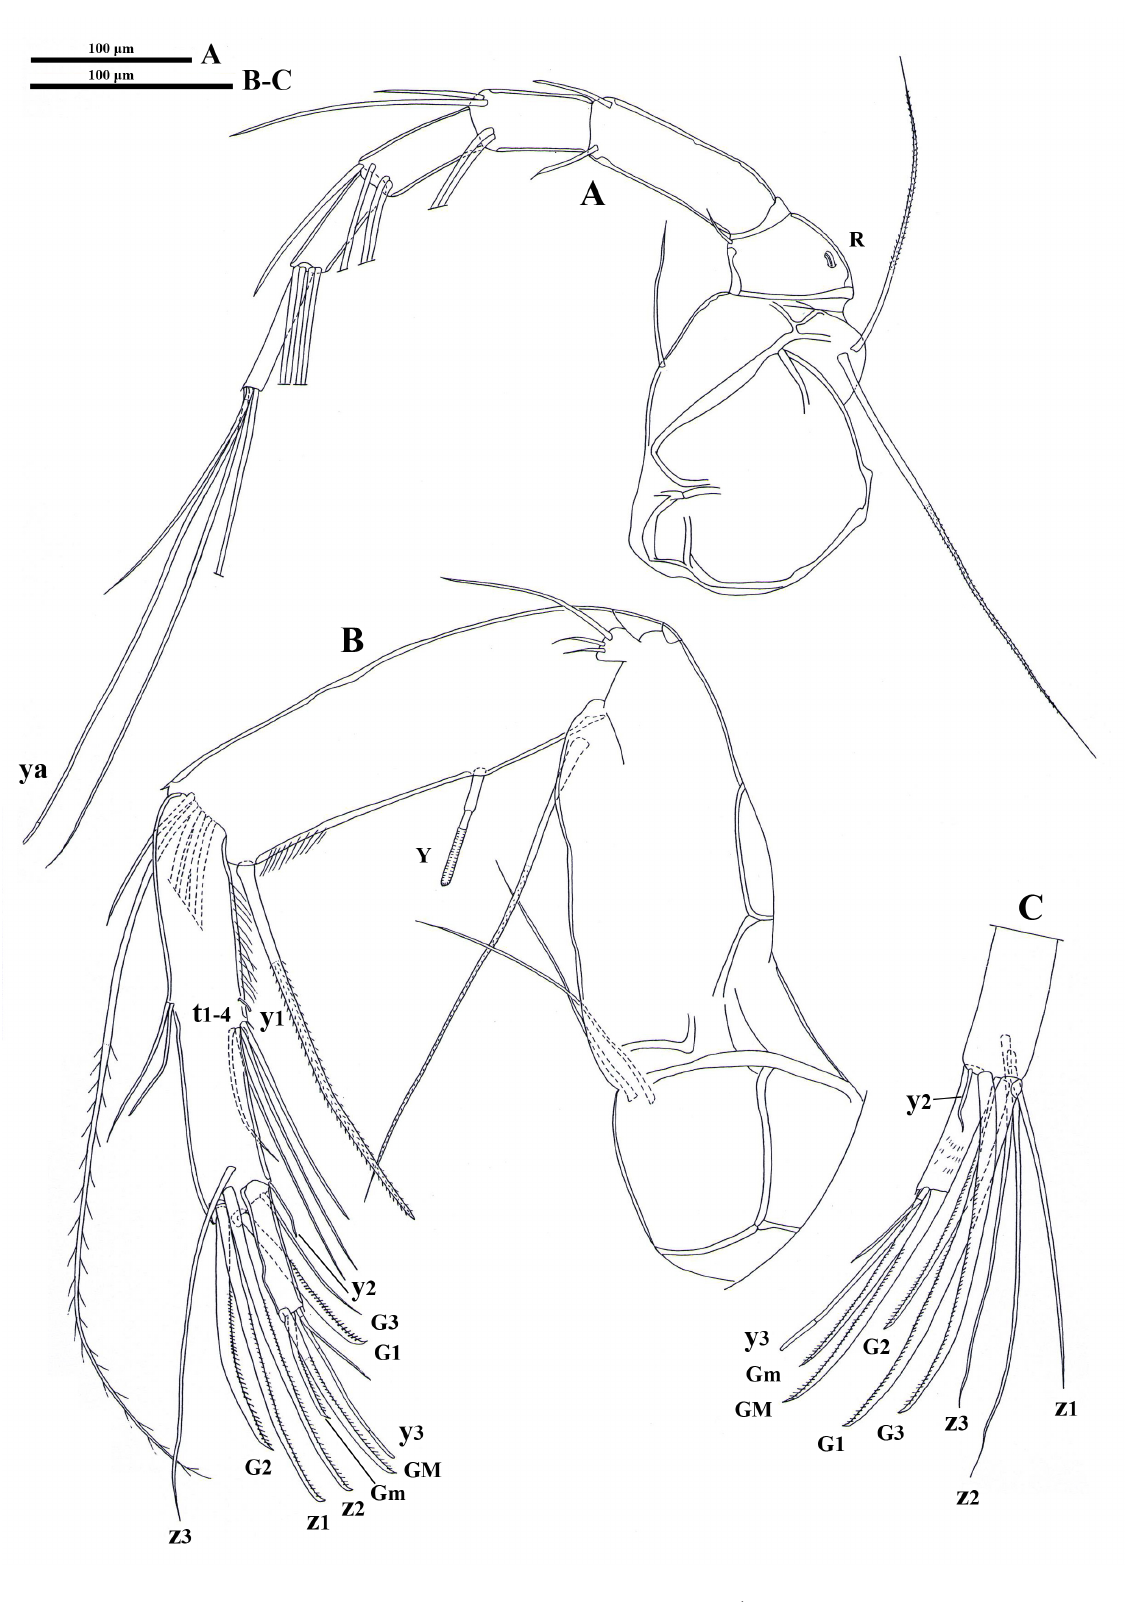
Fig. 4. Martensina thailandica gen. et sp. nov. A–B . Holotype, ♂ (MSU-ZOC.317). C . Allotype, ♀ (MSU-ZOC.318). A . A1. B . A2. C . A2, last two segments. Scale bars = 100